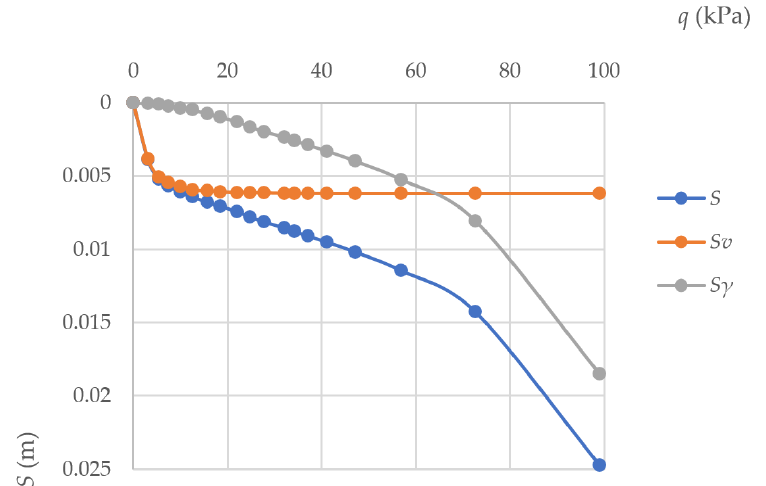
Figure 6. The dependency curves for S γ , S v , and S calculated using Equations (20) and (21) and the load q at d 2 = 2 m when the distance between the fence wall and the point of application of the distributed load is d 2 = 2 m.